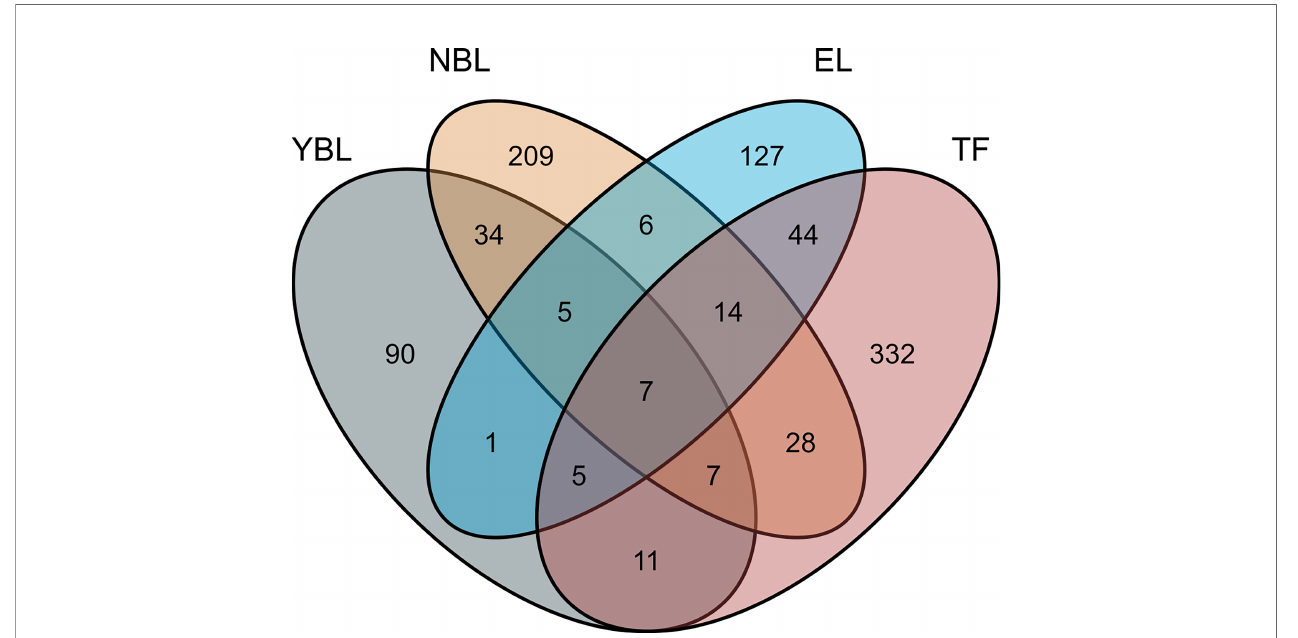
FIGURE 1 | Venn diagram of genes obtained from TWAS identi fi cation in four: Gray, YBL; orange, NBL; blue, EL; pink,